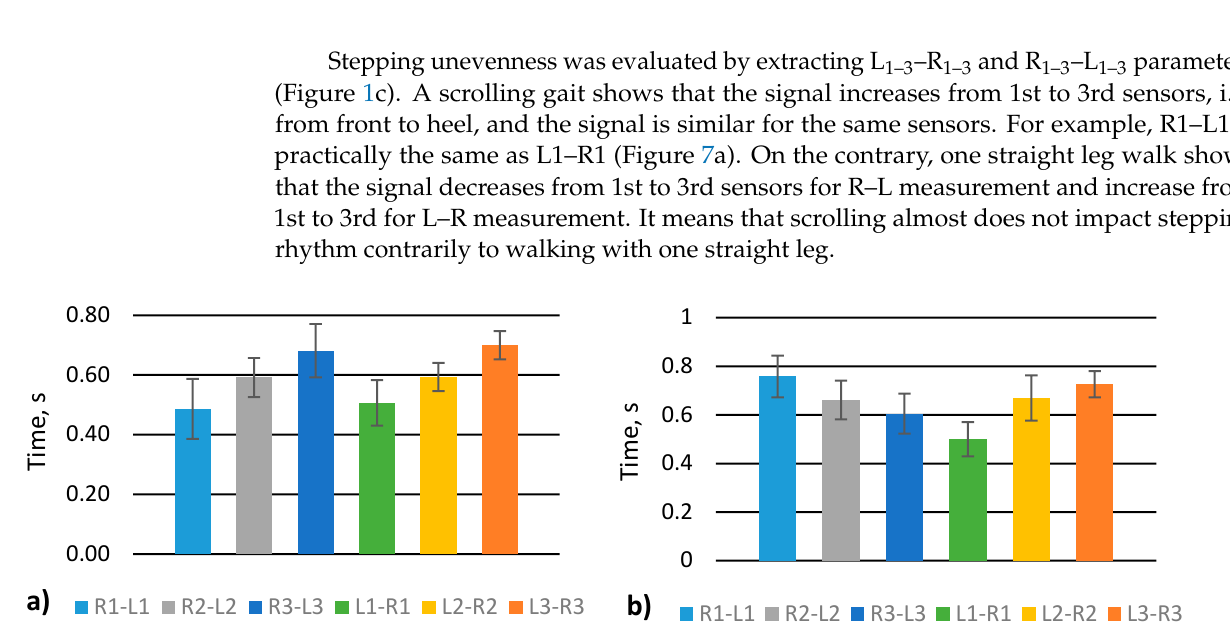
Figure 7. Analysis of stepping unevenness of various gaits: ( a ) scrolling; ( b ) walk with one straight leg. The gait parameters detected by various methods and different types of sensors are provided in Table 1. Some of the methods implement IMUs [28,29,31], accelerometers [2,32], or reflective markers mounted on the body. In the case of IMUs or accelerometers, a huge processing power is needed to define essential gait parameters in real-time.